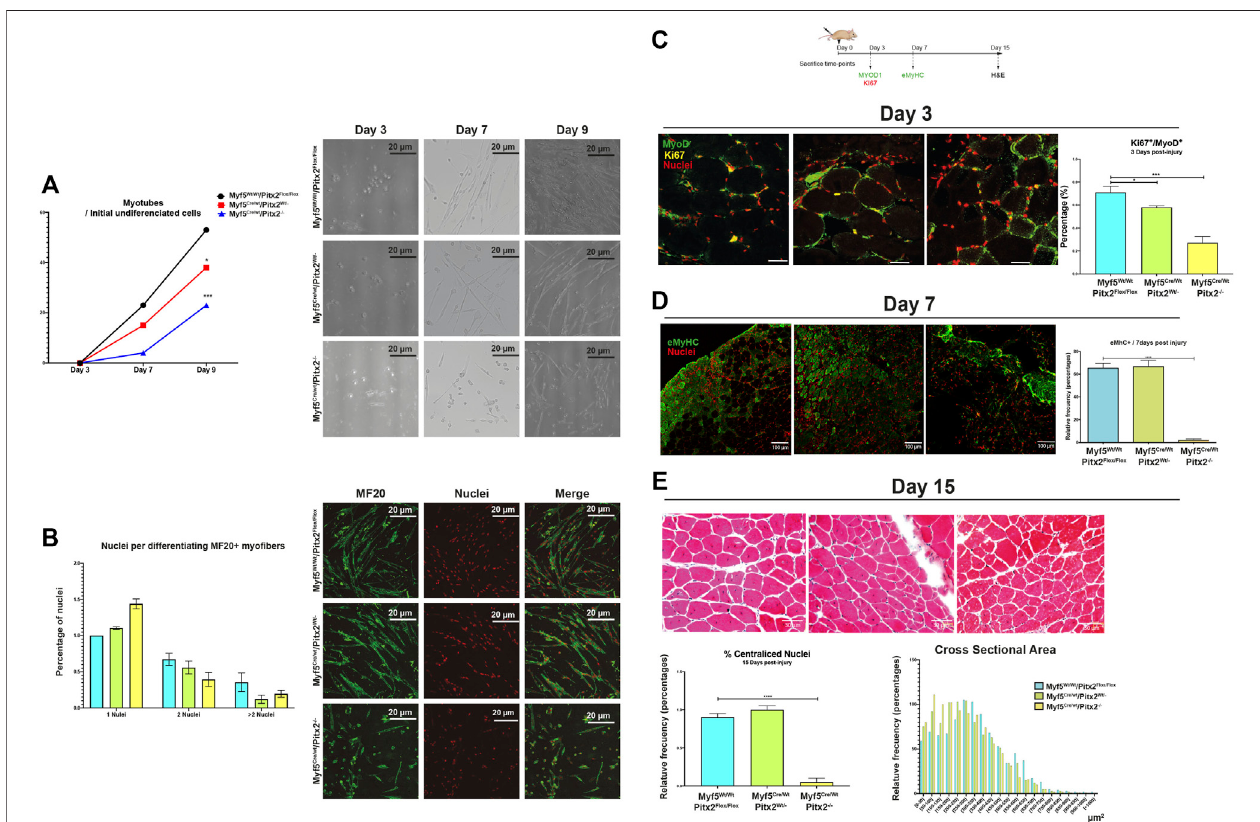
FIGURE10| Myf5 Cre/Wt /Pitx2 − / − miceshowaltered muscleregeneration. (A)